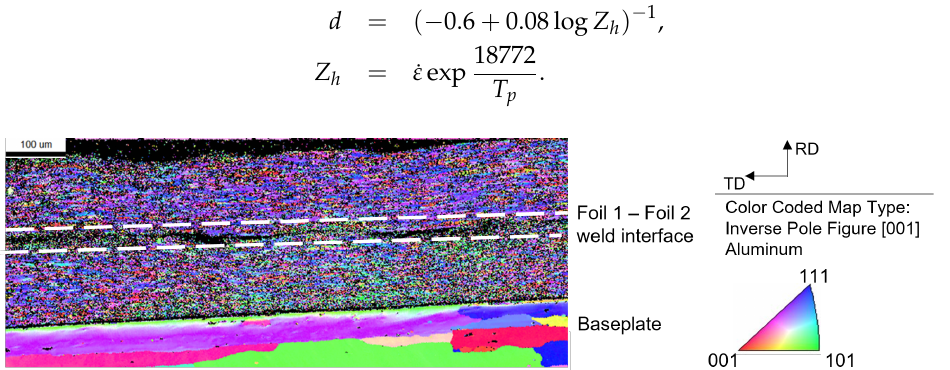
Figure 2. The un-smoothed inverse pole figure (IPF) shows the point-by-point orientation of the sample. The two-layer Al 6061-H18 sample was fabricated on an Al 6061-T6 baseplate using the following settings: 29 µ m weld amplitude, 5000 N weld force, and 84.67 mm/s (200 in/min) weld speed. Black regions are areas that did not provide a high-confidence data fit. The different colors denote the different orientations of each